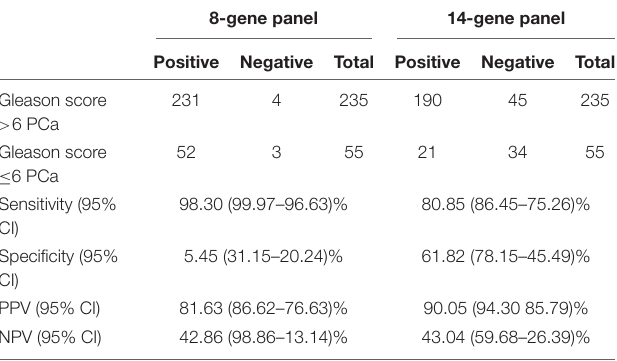
TABLE 2 | Sensitivity, specificity, positive predictive value (PPV), and negative predictive value (NPV) of 8-Gene-Panel and 14-Gene Panel for diagnosis of Gleason Score > 6 and Gleason Score ≤ 6 PCa in a 290 prostate specimen cohort.